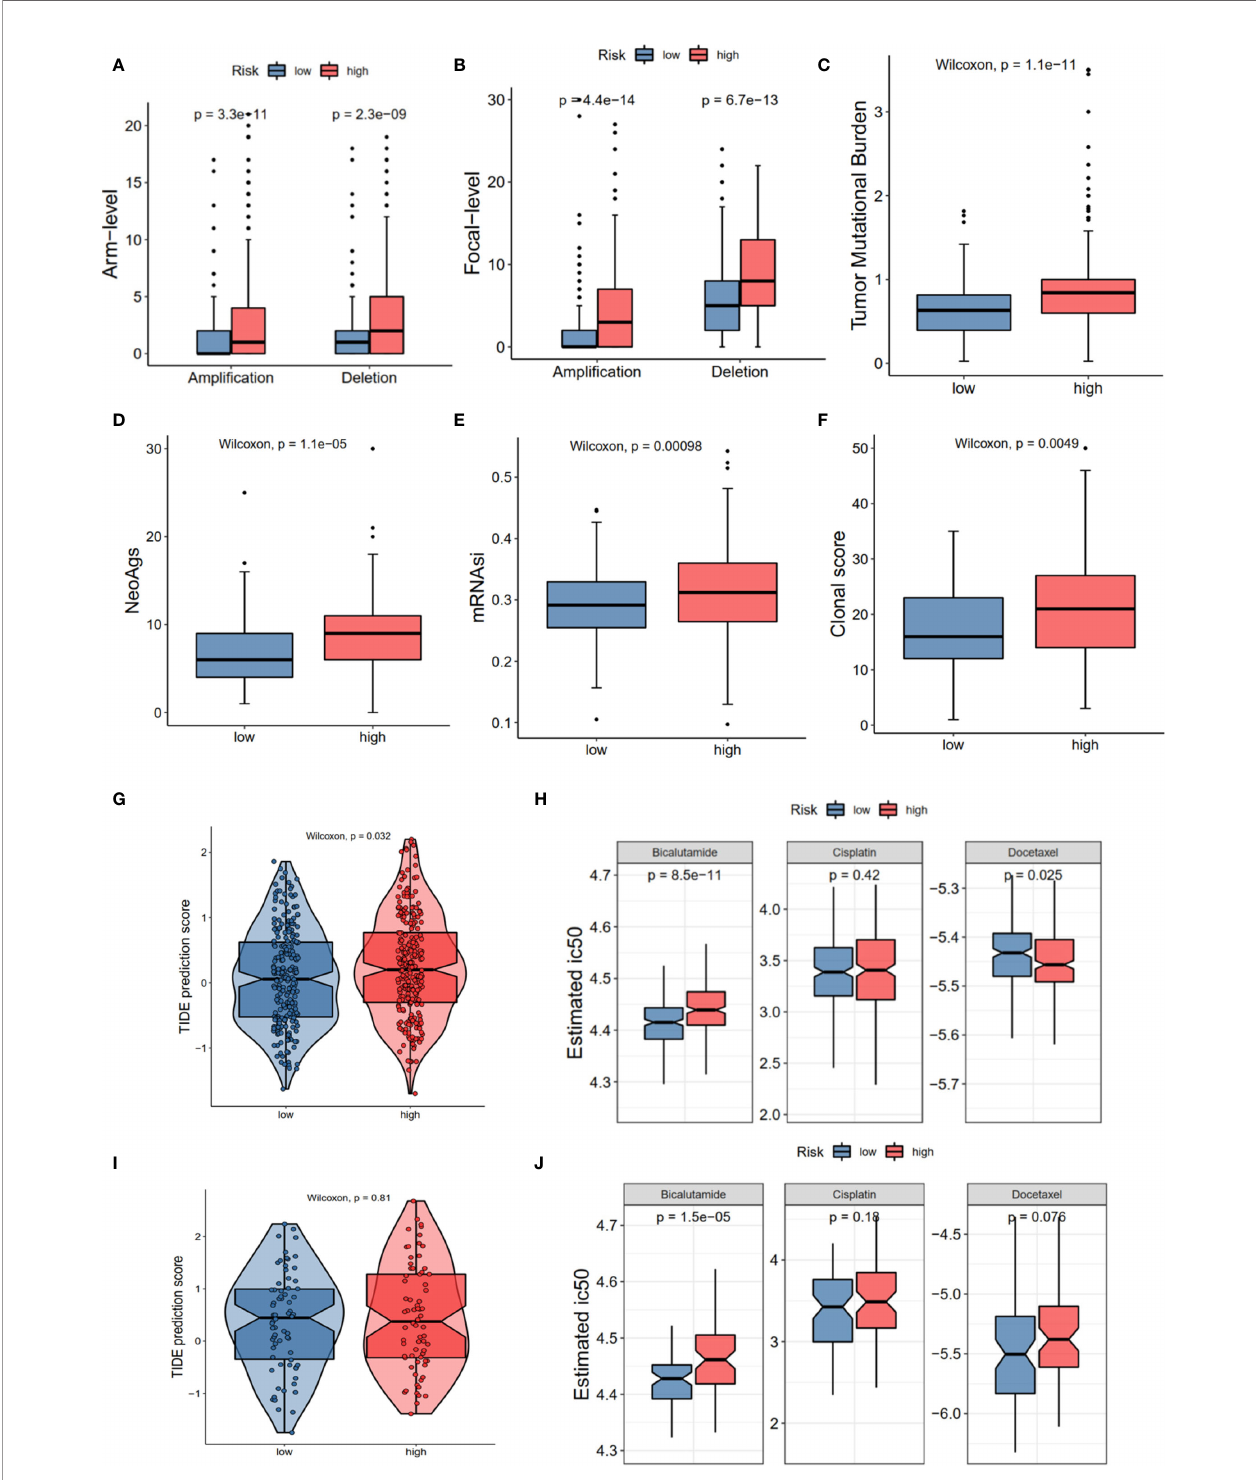
FIGURE 6 | The correlations of different risk group with copy number alterations, tumor mutation burden, neo-antigens, tumor stemness, clonal status and immune-/chemotherapy response. (A) Arm-level copy number ampli fi cation and deletion. (B) Focal-level copy number ampli fi cation and deletion; (C) Tumor mutant burden difference. (D) Neo-antigens. (E) Tumor stemness difference represented by the mRNAsi. (F) Clonal status. (G, H) Immunotherapy response based on TIDE website and estimated IC50 indicates the ef fi ciency of chemotherapy in TCGA. (I, J) Immunotherapy response and estimated IC50 in MSKCC dataset. All the survival analysis are based on the recurrence free survival